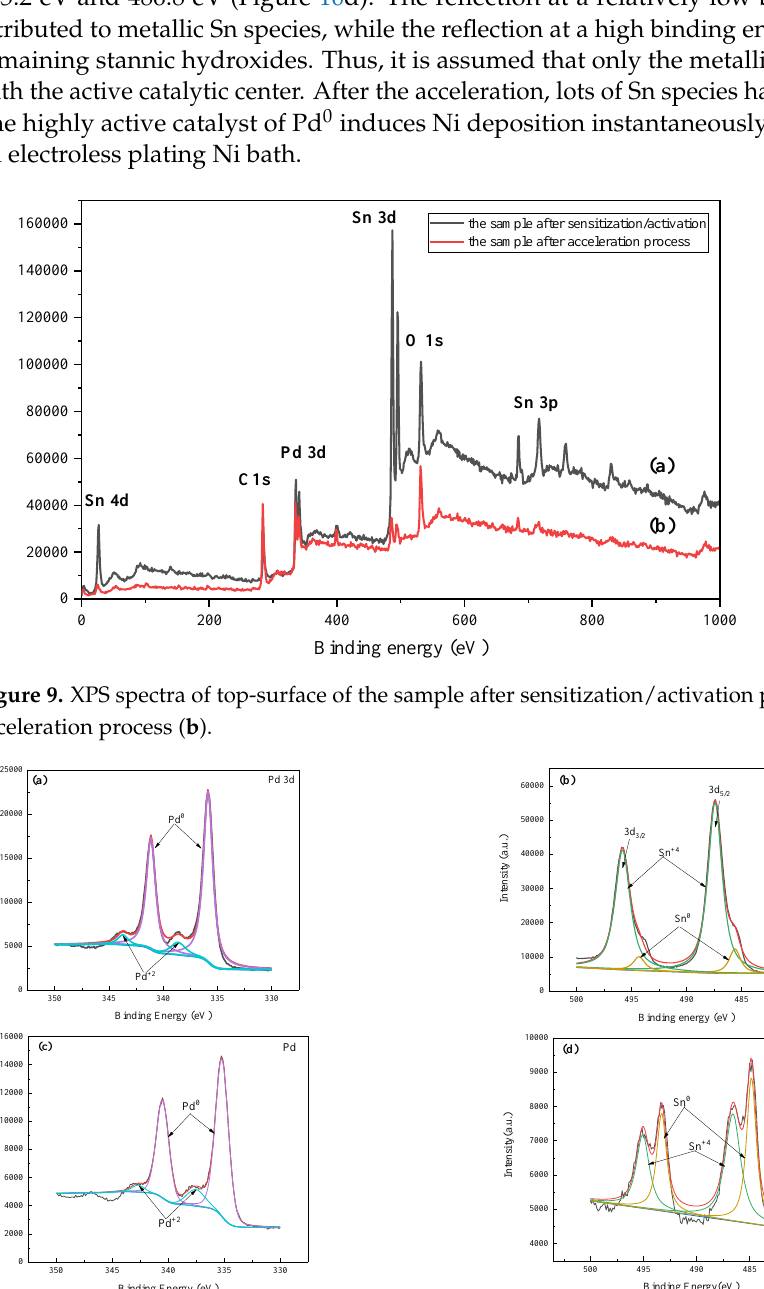
amount of Pd 2+ were present, at the same time there are main Sn 4+ ions at 486.3 eV for